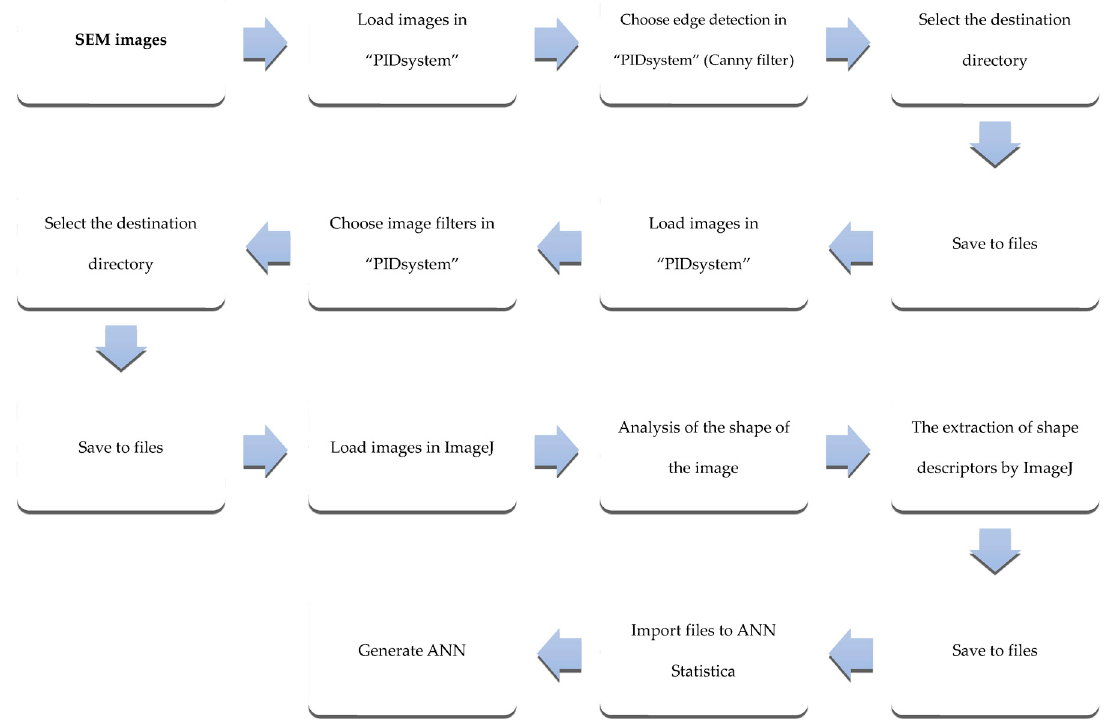
Figure 1. Scheme of the procedure to determine the shape factors to obtain a neural model based on scanning electron microscopy (SEM) images.